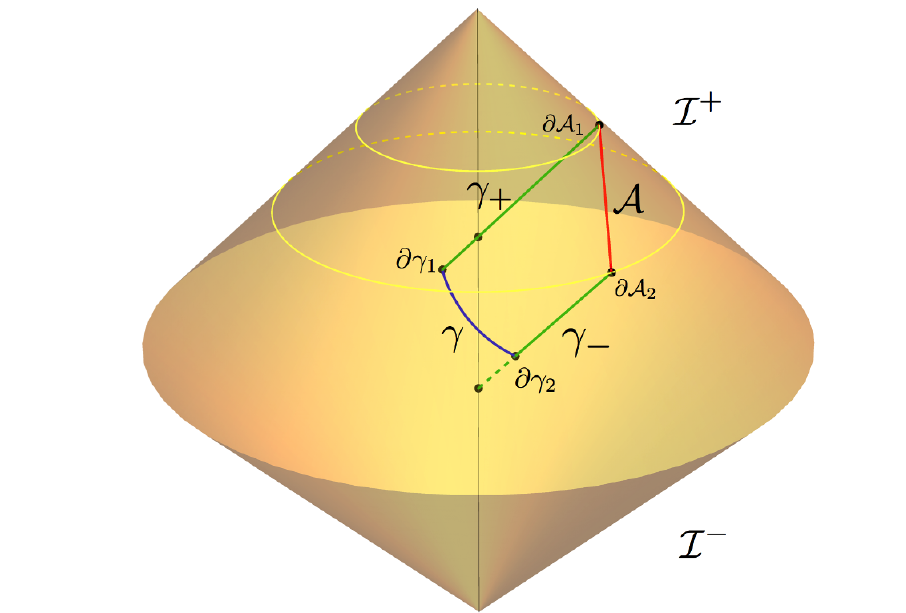
Figure 1 . The red line A on the future null in(cid:12)nity I + is the boundary interval. The blue line (cid:13) is a spacelike geodesic, on which the bulk modular generator vanishes, k bulk green lines (cid:13) + , (cid:13) (cid:0) are null geodesics. The tangent vector on (cid:13) + and (cid:13) (cid:0) are k bulk (cid:13) A = (cid:13) [ (cid:13) + [ (cid:13) (cid:0) is invariant under the modular (cid:13)ow k bulk